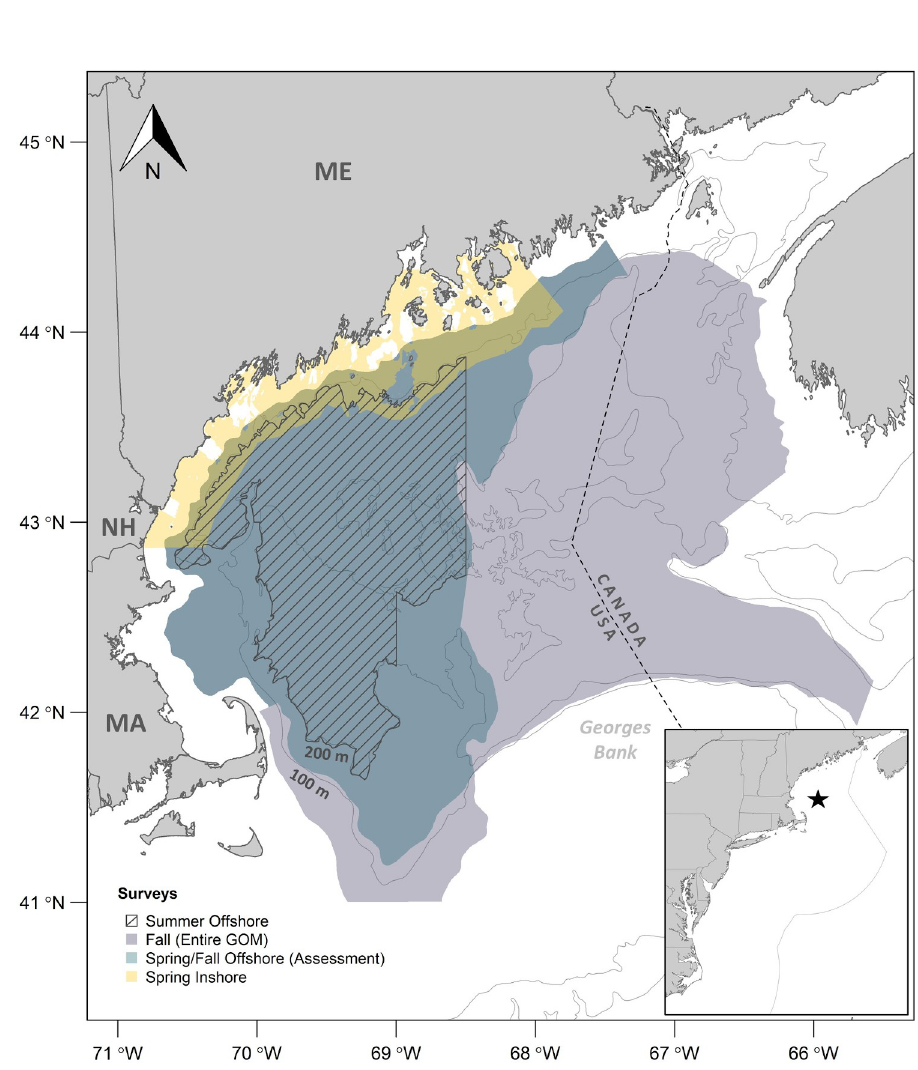
Fig 1. Map of the study area in the Gulf of Maine, USA. Inset shows location of Gulf of Maine in the northwest Atlantic Ocean. Credit: Alicia Miller, NEFSC. ME = Maine, NH = New Hampshire, MA = Massachusetts.